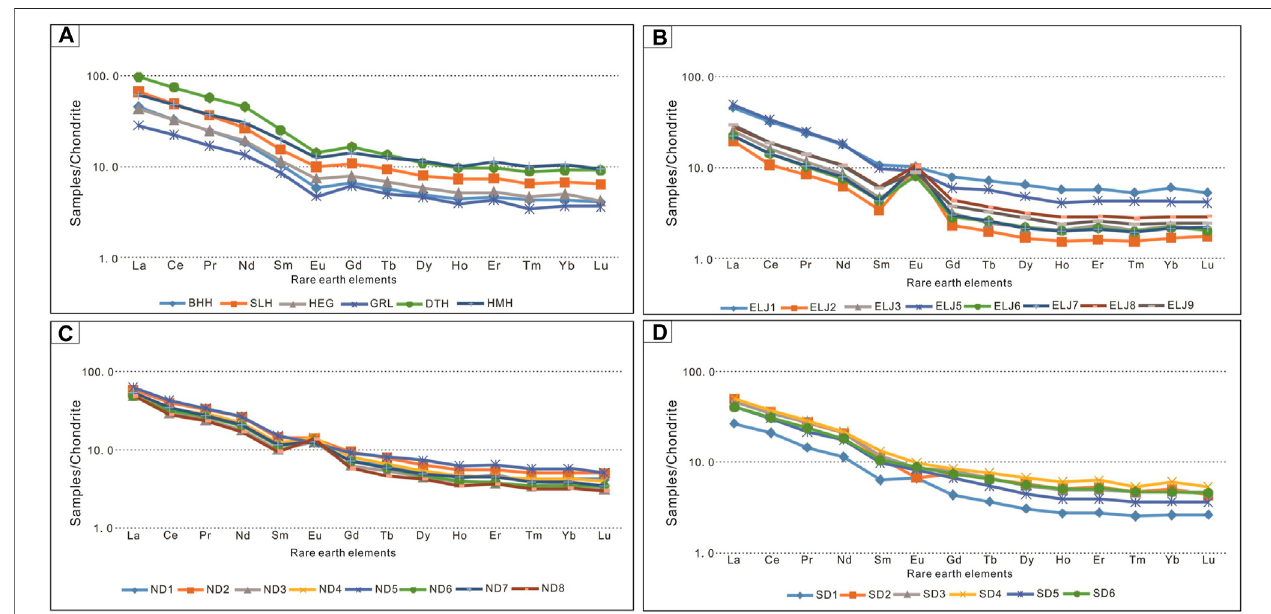
FIGURE 7 | Chondrite-normalized REE patterns for different sediments from the Qinghai Lake area. (A) Samples from rivers and GRL foreshore, (B) samples from Erlangjian beach bar (ELJ), (C) samples from Niaodao beach (ND), and (D) samples from aeolian sand dune (SD), respectively.